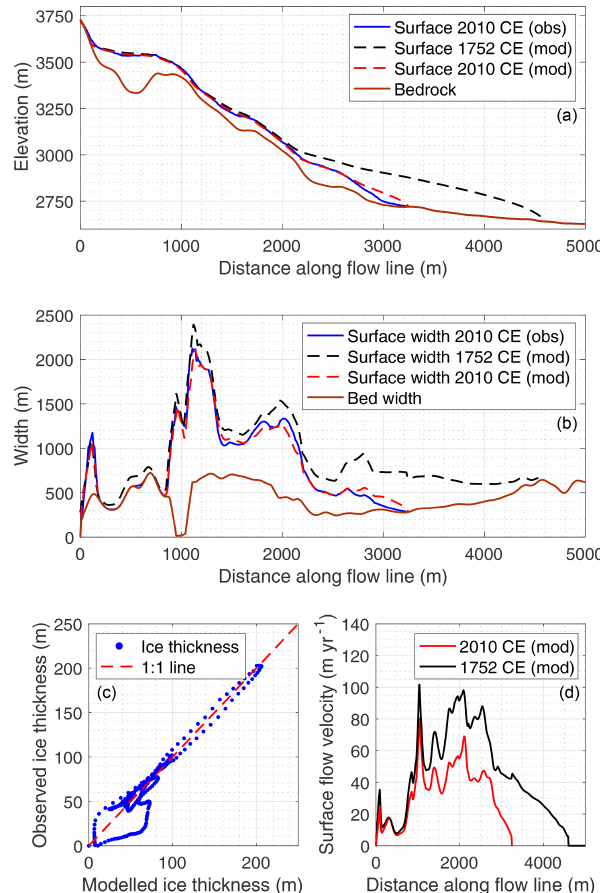
Figure 6. Calibrated flow model, showing (a) the observed and modelled bedrock and surface elevation and (b) bed and surface width for the current (2010CE) and initial state (1752CE), (c) mod- elled vs. observed ice thickness for 2010CE conditions and (d) cur- rent (2010CE) and initial (1752CE) surface flow velocity along the flow